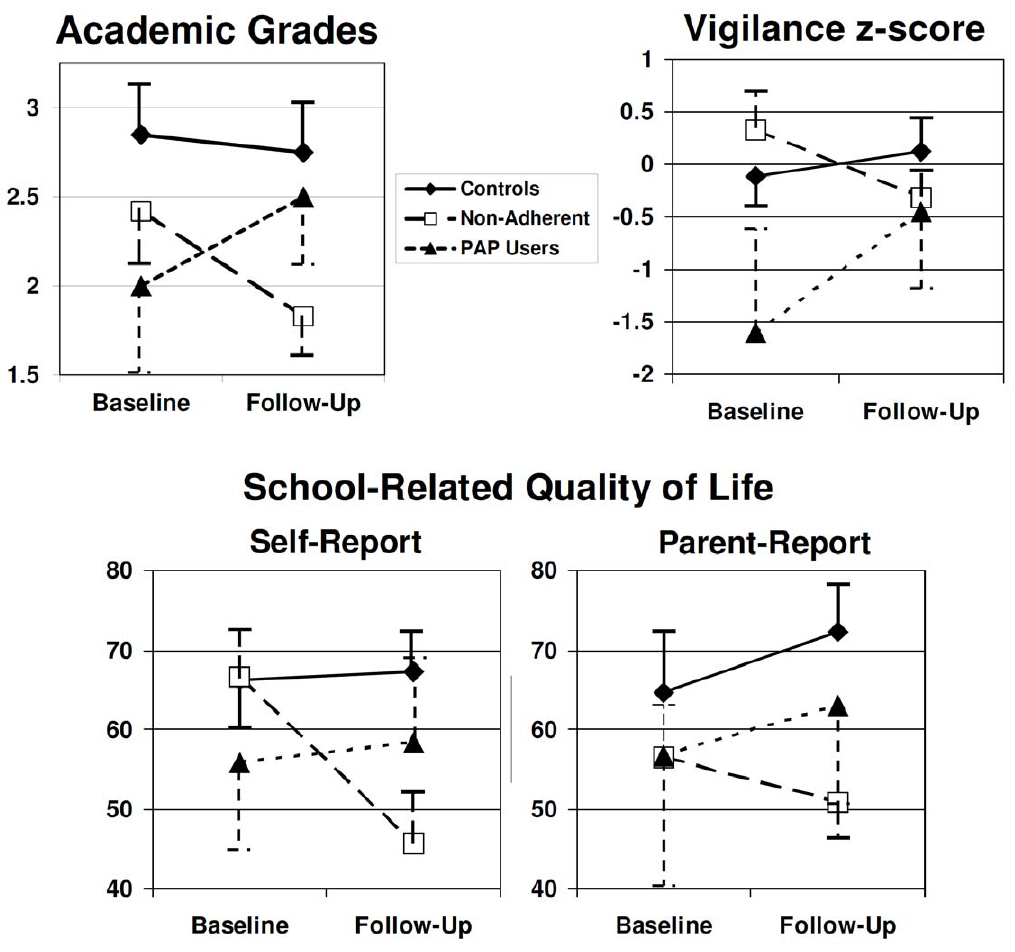
Figure 1. Change over time in sustained attention/vigilance and academic performance among adolescents who used PAP, those who were non-adherent to PAP treatment, and untreated controls. Error bars reflect the standard error of the mean. Higher scores denote better functioning. Self-reported academic grades are expressed according to the US 4-point convention (max =4.0; see [3]). Vigilance is expressed as an age-adjusted z-score compared to published norms [14]. Academic quality of life is expressed on the 0–100 scale used by the Peds-QL, on which completely healthy individuals average around 80 [13].